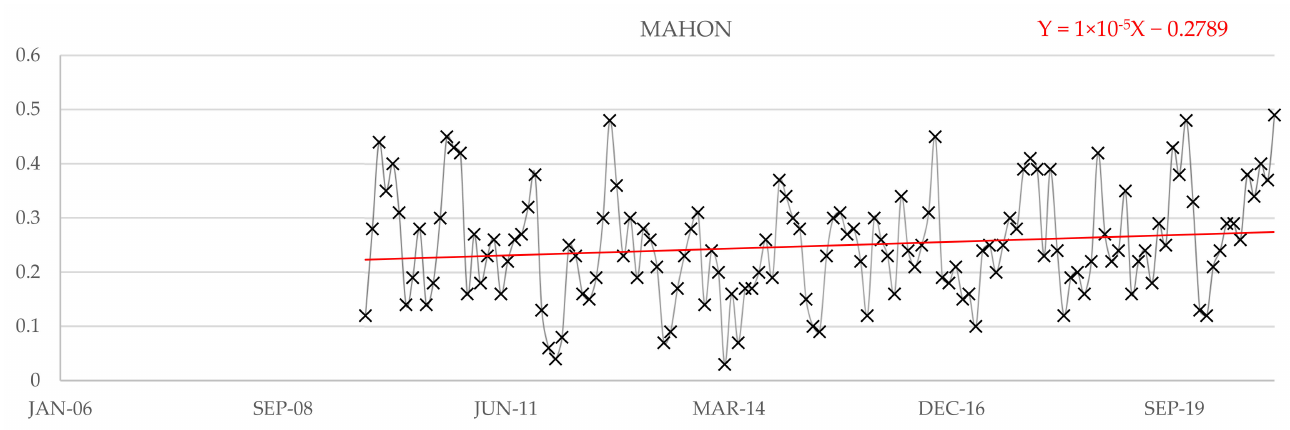
Figure 37. Evolution of SL maxima in